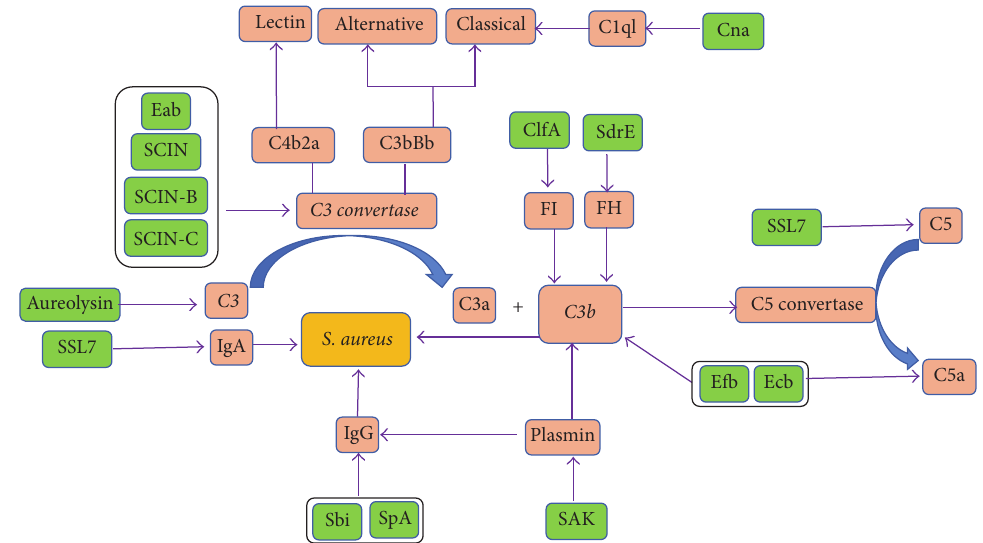
Figure 2: Staphylococcus aureus was interfered with chemotaxis and activation of